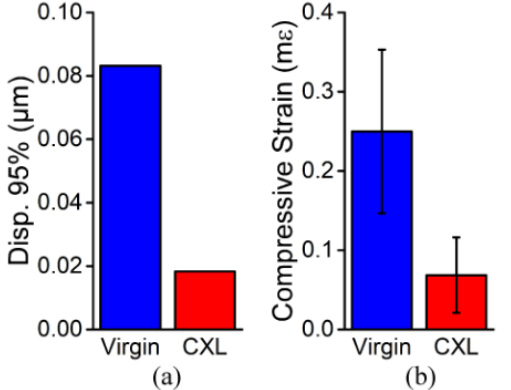
Figure 9. Quantitative analysis of the full-CXL in vivo rabbit cornea (N = 1). ( a ) 95th percentile of the displacement and ( b ) average compressive strain before and after CXL. Data are presented as the intra-sample mean ± standard deviation in ( b ).